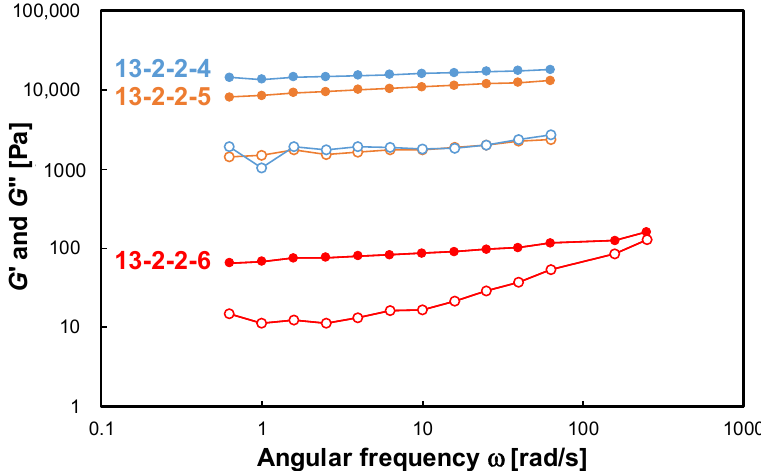
Figure 6. Angular frequency dependence of G ′ (solid circles) and G ″ (open circles) of 13-2-2- n ( n = 4, 5, and 6) aqueous solutions at 25 °C.